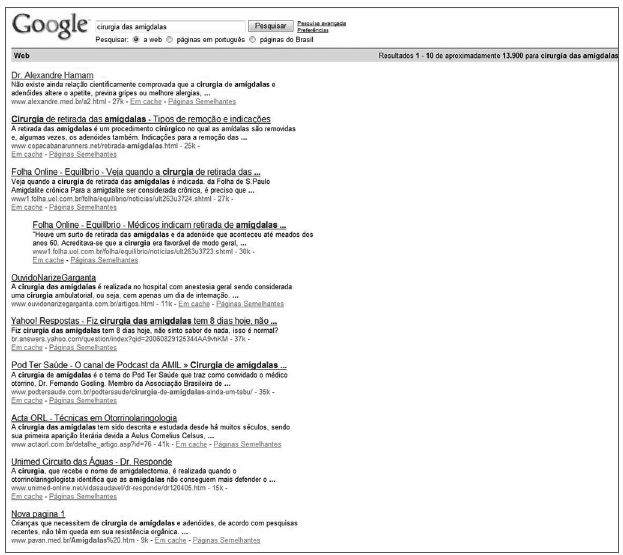
Figure 2. Top search results on GOOGLE for keyword ’tonsil surgery’ (cirurgia das amígdalas).